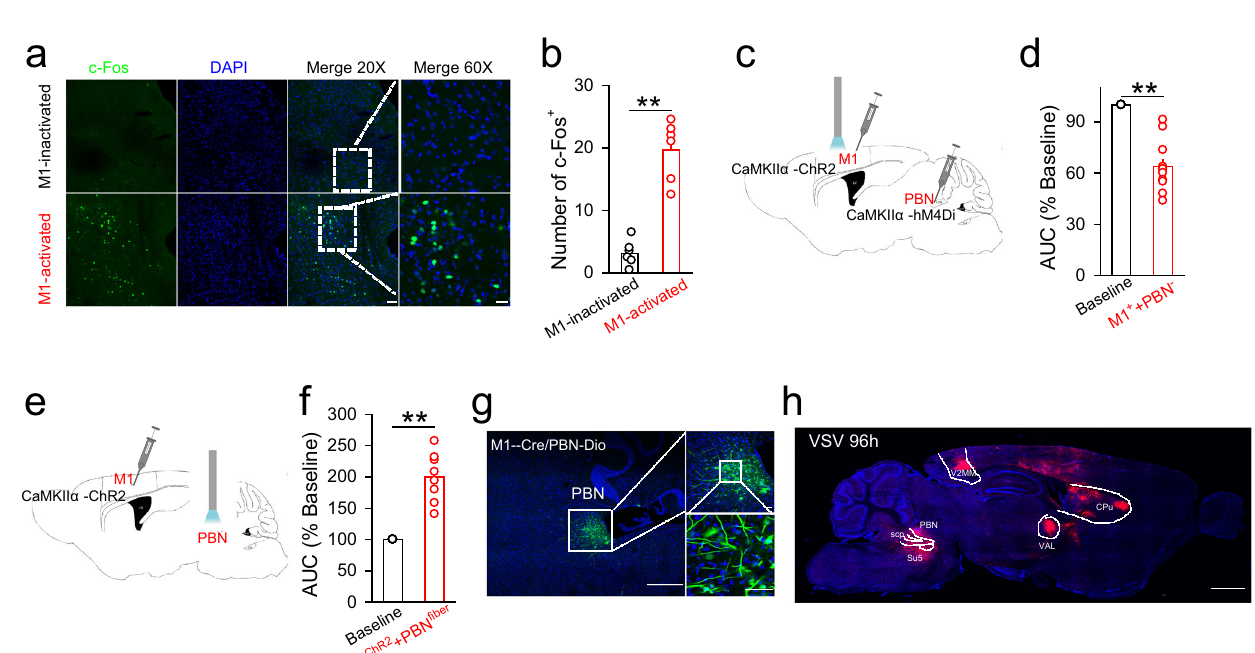
Fig. 5 | The M1-PBN neuralcircuitwasinvolvedinthe regulationofswallowing function. a , b The expression of c-Fos-positive neurons in the PBN following optogenetic activation of M1 neurons (M1-activated, injection of AAV2/9-CaMKII α - ChR2-mCherry into the M1 and blue light stimulation) or not (M1-inactivated, injection ofAAV2/9-CaMKII α -mCherry into the M1).Green: c-Fos-positive neurons. Blue: Nuclei. Scale bar, 20×: 100 μ m, 60×: 50 μ m ( a ). M1 neurons activation increased the expression of c-Fos in the PBN (two-tailed Student ’ s unpaired t -test, N =6 per group; t =7.717, ** P <0.01) ( b ). c , d Diagram showing optogenetic acti- vation of M1 neurons and inhibition of PBN neurons. AAV2/9-CaMKII α -ChR2-